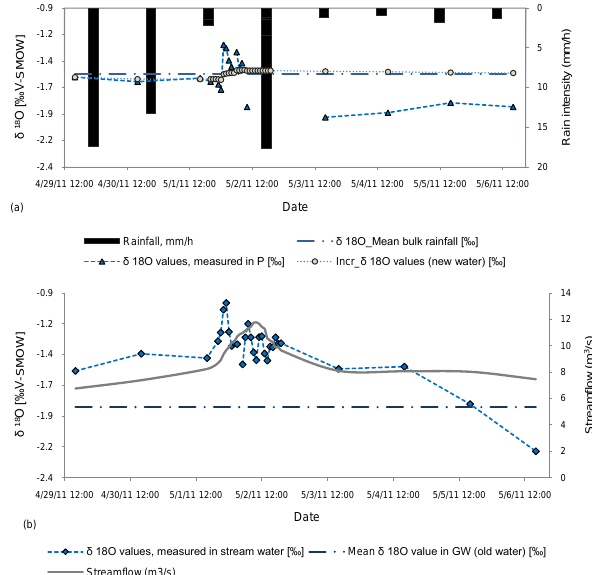
Figure 8 Hourly rainfall and variations of δ 18 O in rainfall (a), discharge and variations of δ 18 O in the stream water (b) during the 29 th April 2011 to 6 th May 2011 storm event. Fig. 8. Hourly rainfall and variations of δ 18 O in rainfall (a) , dis- charge and variations of δ 18 O in the stream water (b) during 29 April 2011 to 6 May 2011 storm event.